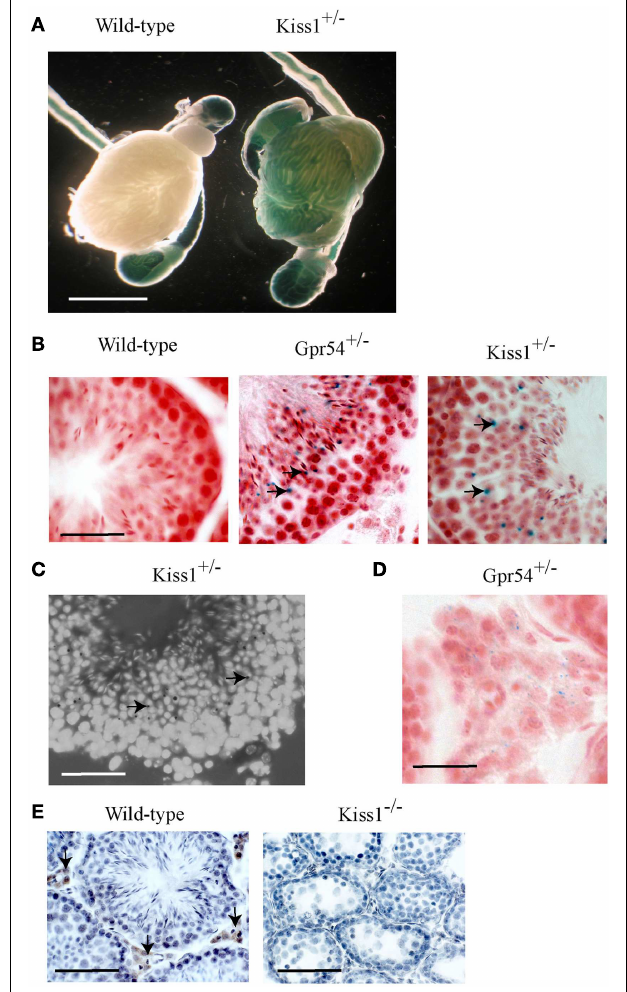
FIGURE 1 | Kiss1 and Gpr54 expression in the mouse testes . (A) Expression of Kiss1 in seminiferous tubules of the testes visualized by X-gal staining (blue) for β -galactosidase activity. Note the non-specific staining in the epididymis and vas deferens of the wild-type testes. Scale bar = 5mm. (B) Cryosections of testes from adult wild-type, Gpr54 + / − , and Kiss1 + / − mice showing expression (arrowed) localized to spermatid cells of seminiferous tubules. Sections were stained for β -galactosidase activity (blue) and counterstained with Saffronin (red). Scale bar = 100 µ m. (C) Testes cryosection from Kiss1 + / − mice stained for β -galactosidase activity (black dots, arrowed) and counterstained with DAPI to visualize cell nuclei illustrating clearer expression in spermatid cells. Scale bar = 100 µ m. (D) Low expression of Gpr54 in Leydig cells visualized by X-gal staining. Scale bar = 50 µ m. (E) Kisspeptin immunoreactivity localized to Leydig cell in wild-type mice (arrowed) but not Kiss1 mutant mice. Scale bar = 200 µ